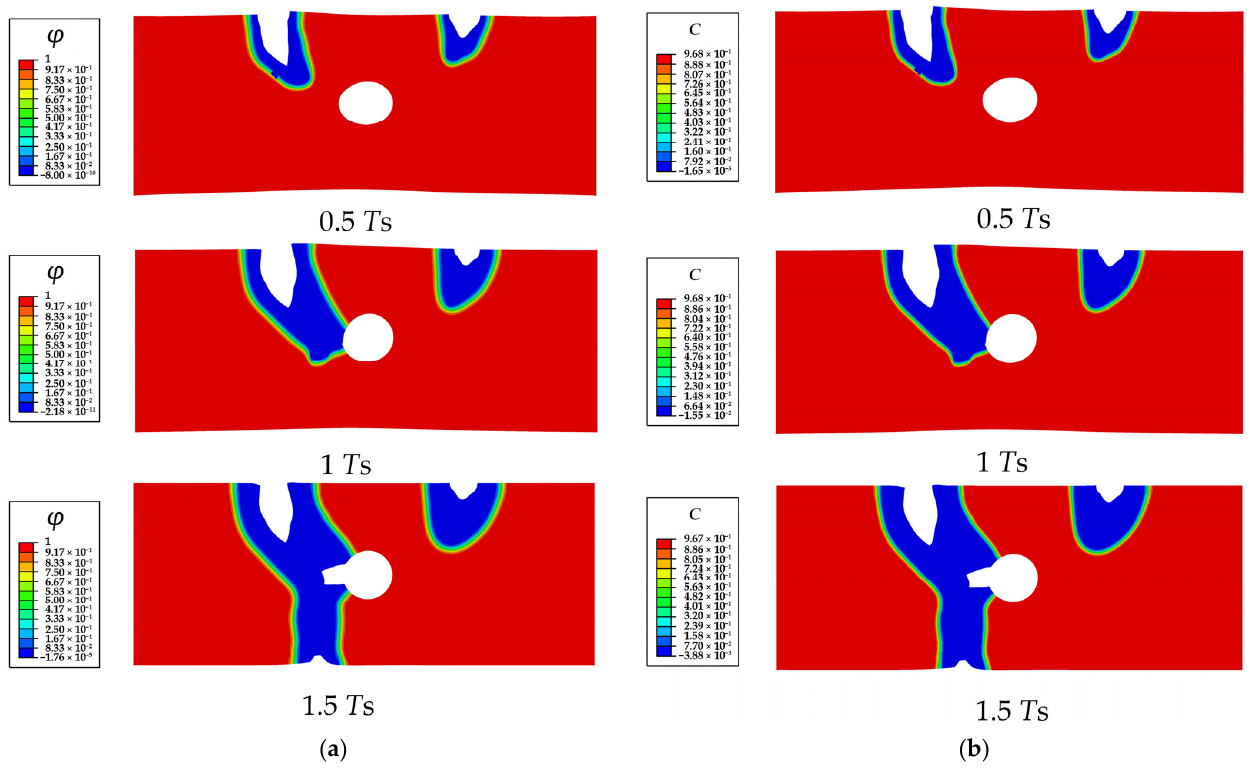
Figure 8. The SCCD process contours of a Mg single crystal with a cavity ( R = 0.25 μ m): ( a ) phase field order parameter ϕ , ( b ) dimensionless concentration c .